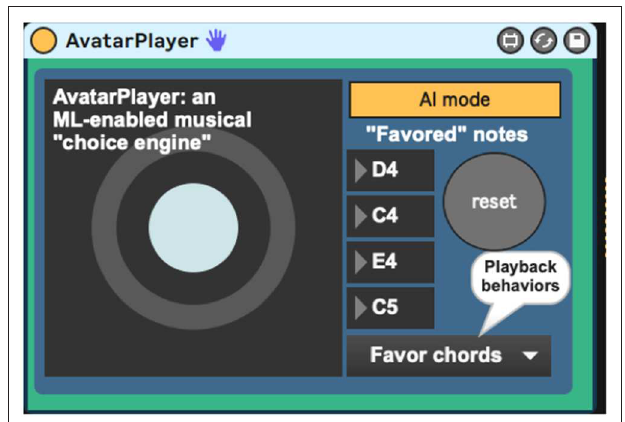
FIGURE 4 | AvatarPlayer.amxd, a program that uses machine learning to generate new musical choices in a given player’s style.